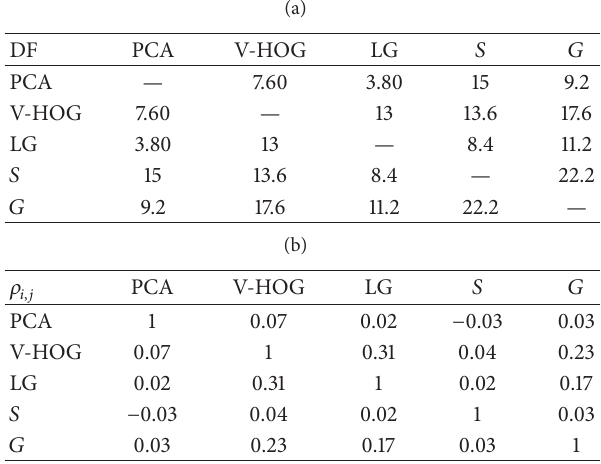
Table 12: Diversity measures for the right region: (a) Double Fault and (b) correlation